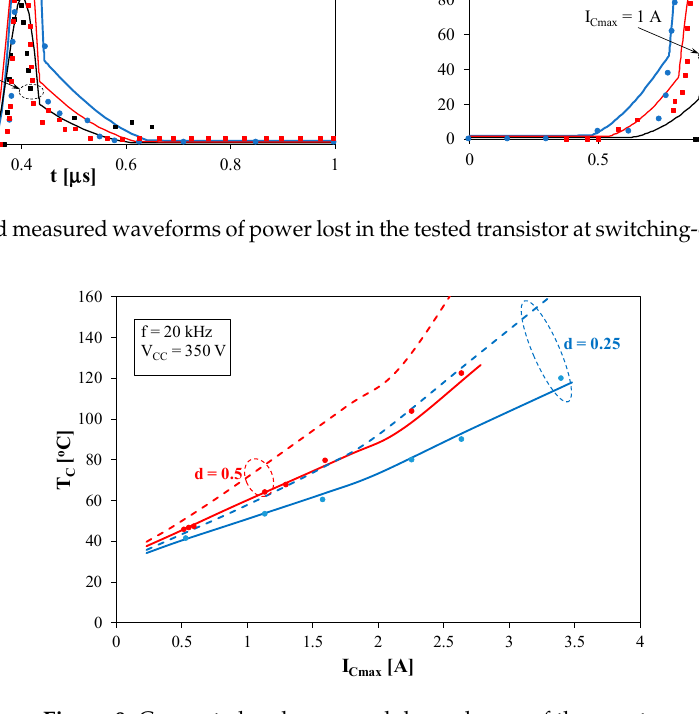
Figure 9. Computed and measured dependences of the case temperature of the transistor operating in the circuit of a switch at the steady state on the maximum value of the collector current. In all these figure’s points represent the results of measurements, and solid lines—the results of computations obtained by means of the formulated model (ETN). Dashed lines represent the results of computations obtained with the use of the same electrothermal model containing the linear thermal model (ETL), in which the dependence R th ( T j , T a ) is omitted. At first, the DC characteristics of the considered transistor are presented,